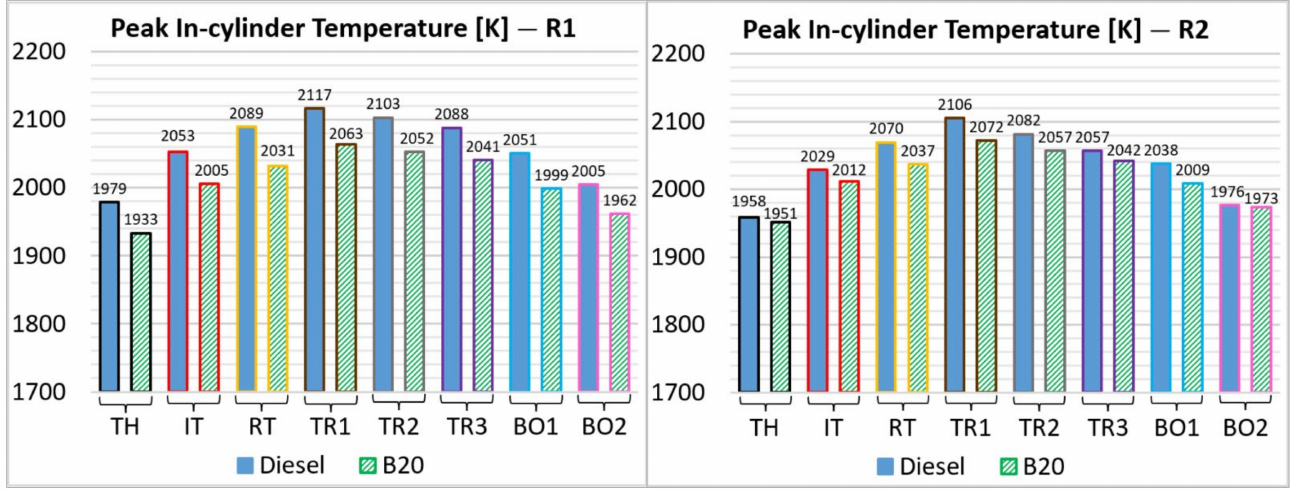
Figure 8. Peak in-cylinder temperature variation by different shapes of ROI.